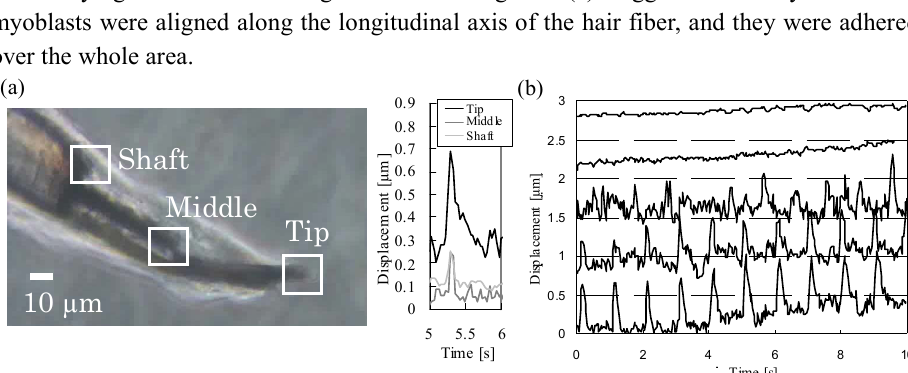
Fig. 4 Displacements of the tweezers. (a) Displacements of three points were calculated using binary video images. (b) Displacements of the tip for various duration times of pulse stimulation. Electric stimulation was applied as a unipolar square voltage: pulse width, 10 to 400 ms; amplitude, 50 V; frequency, 1 Hz. The curves from bottom to top are in the order 10, 20, 30, 300 and 400